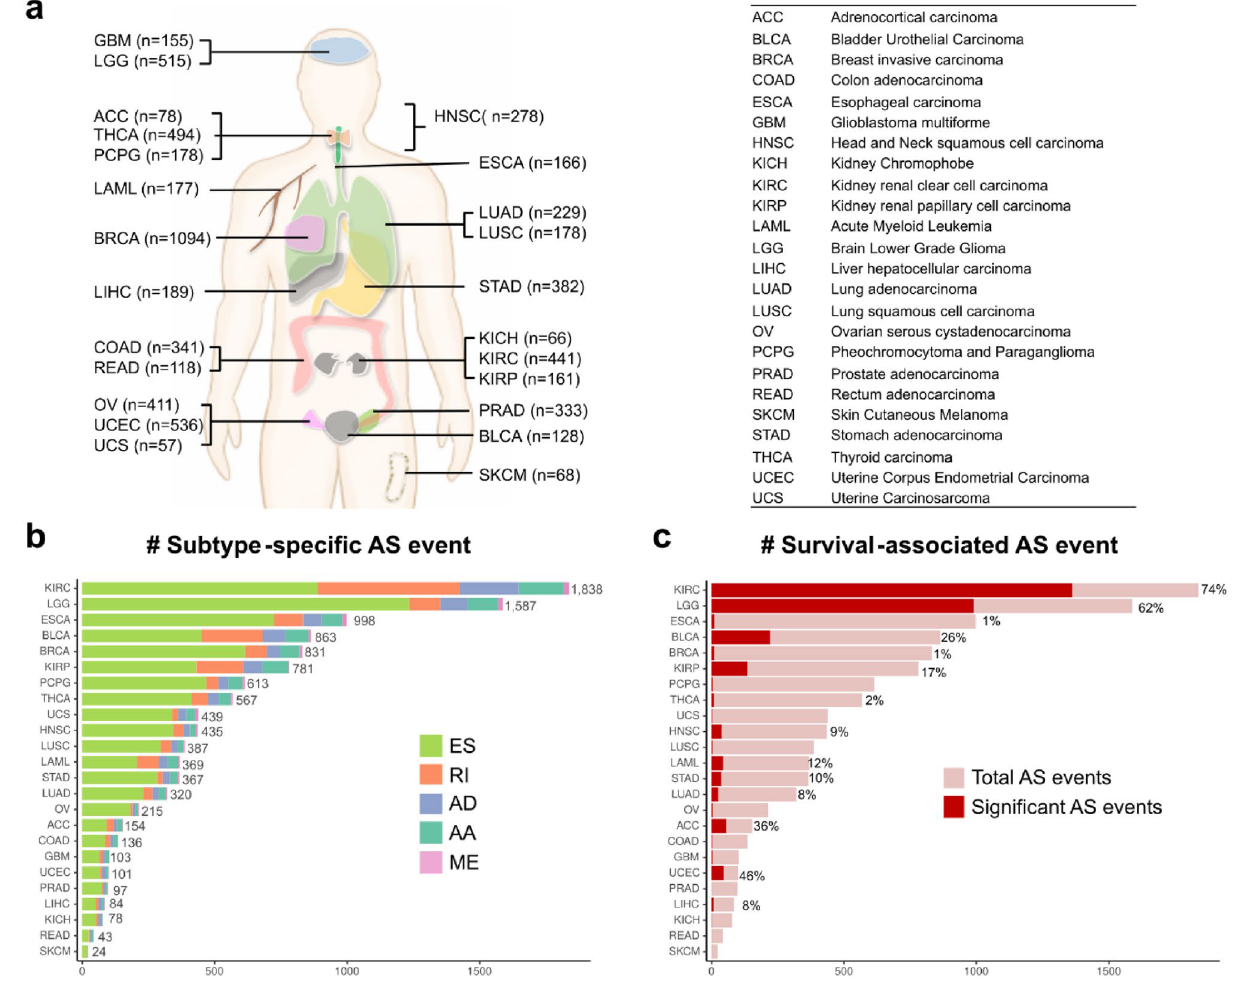
Figure 2. Landscape of subtype-specific AS in TCGA. (a) The 24 cancer types included in AS-CMC and number of samples in each cancer type. The TCGA abbreviations and full names are displayed on the right side. (b) The number of subtype-specific AS events by splice types. The subtype-specific AS events were selected based on the ANOVA test ( p < 0.001 and adjusted R 2 > 0.1). (c) The fraction of survival-associated AS events among subtype-specific AS events. The fraction is marked by dark red color and is also shown as percentage on the right side of each bar. X-axis indicates the number of AS